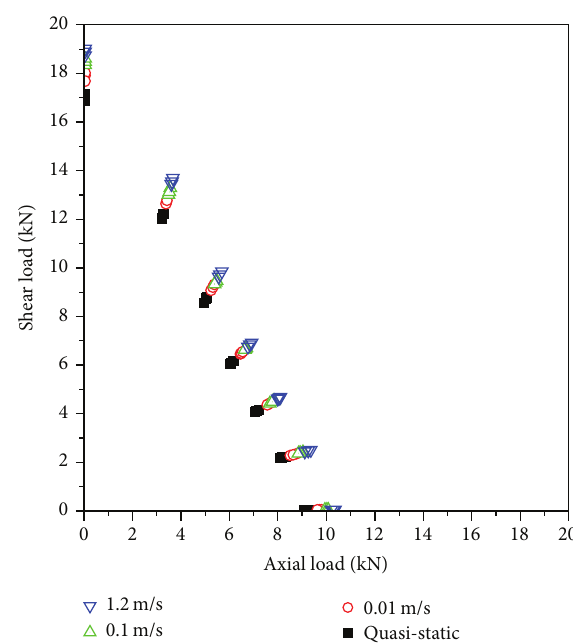
Figure 10: Dynamic failure contour of the DP590 spot weld with various tensile speeds.